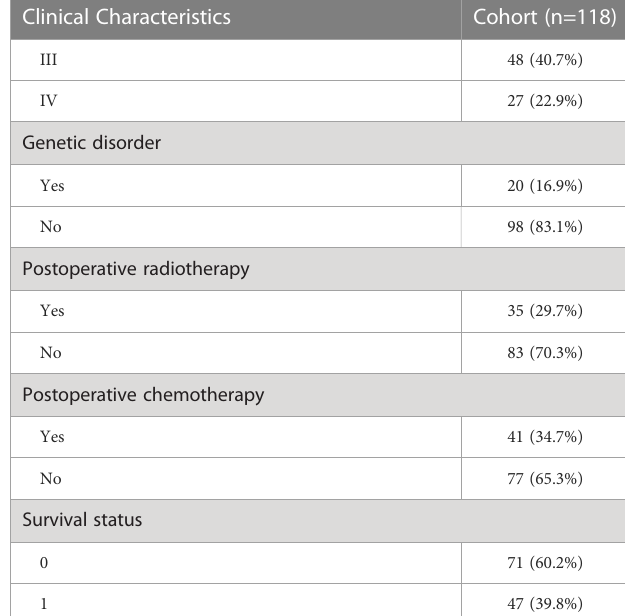
TABLE 1 Clinicopathological